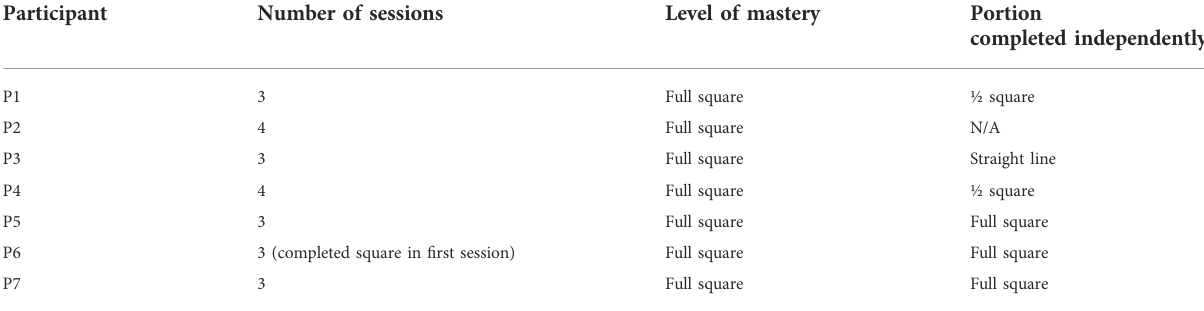
TABLE 4 Year 2, Phase 1: Participants ’ completion.